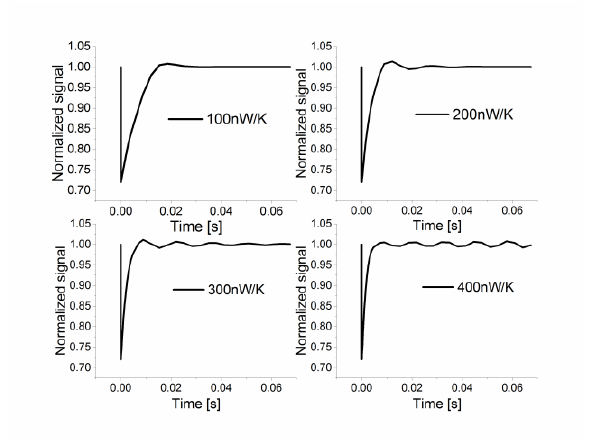
Fig. 7. Normalized TES current signals with different thermal conductance G . 100 nW/K (left-top), 200 nW/K (right-top), 300 nW/K (left-bottom), 400 nW/K